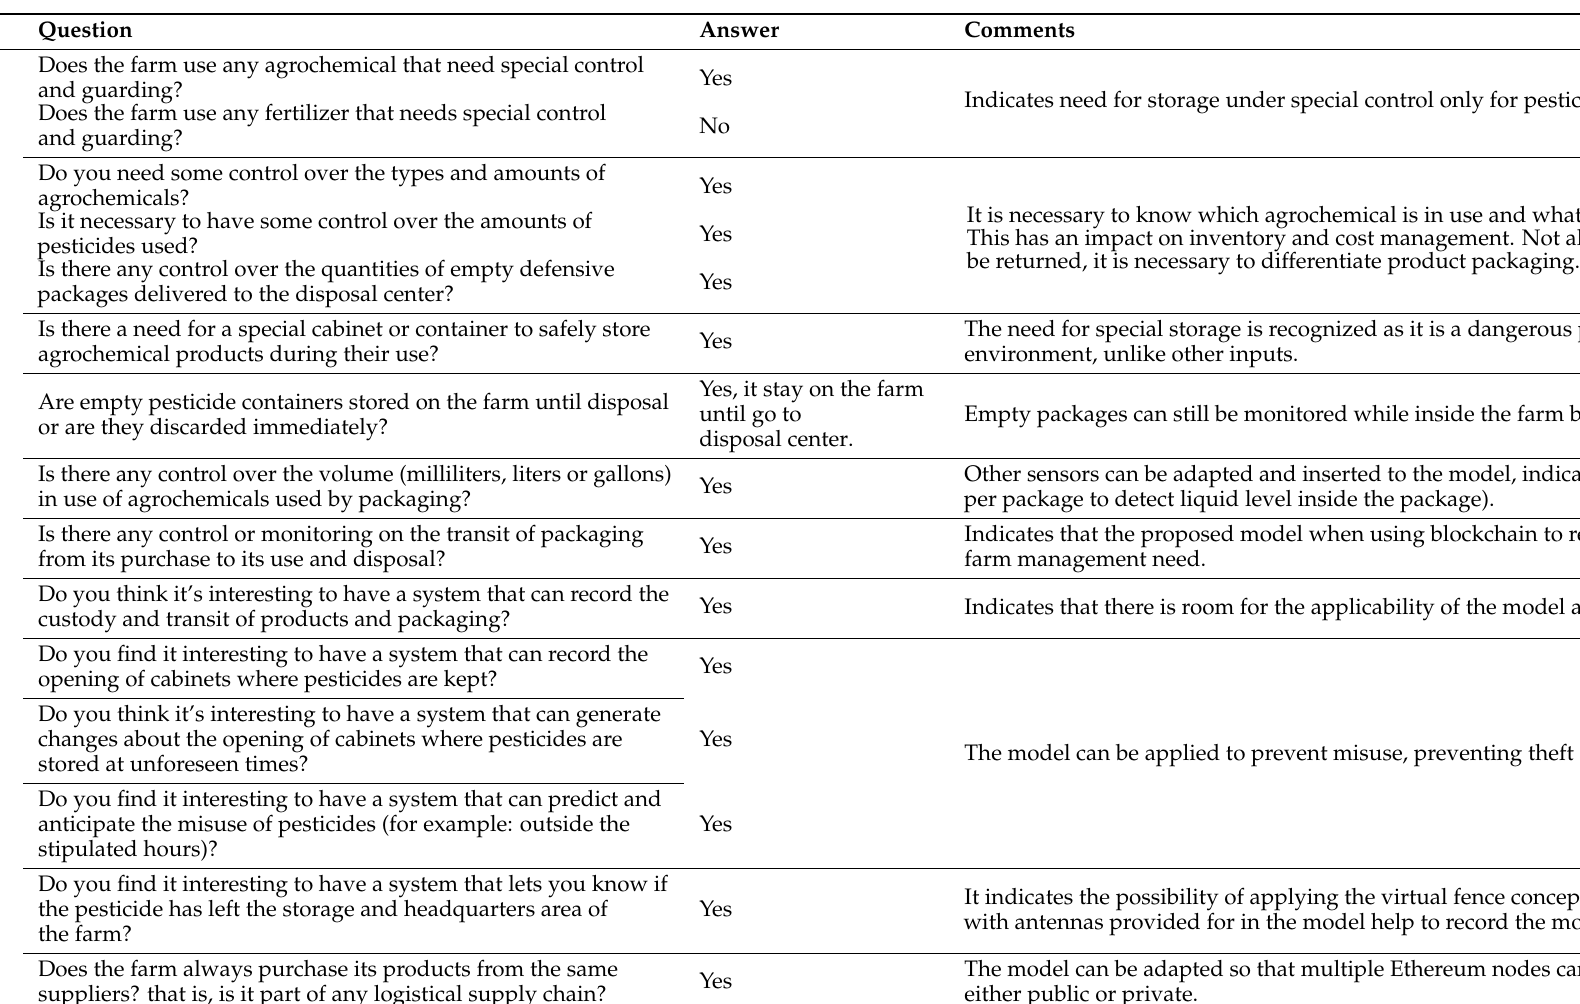
Table 5. Questionnaire with the farm owner, questions